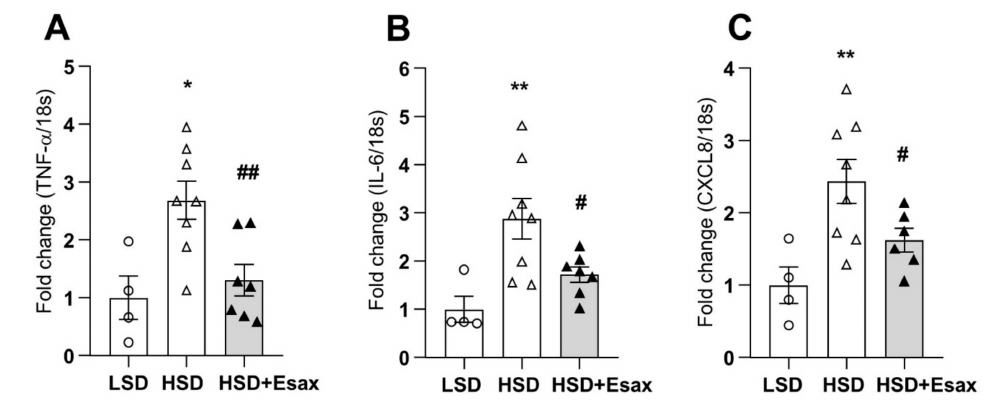
DSS rats (Figure 5C). Esaxerenone treatment caused a significant decrease in MDA level in cardiac tissues from DSS rats.